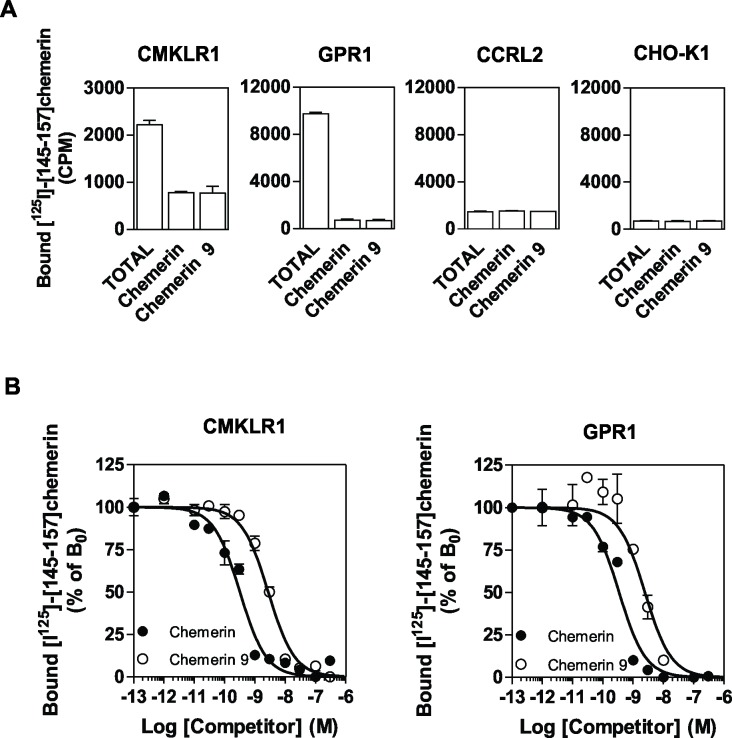
Peptide binding assay.A CHO-K1 cells expressing CMKLR1, GPR1 or CCRL2 were incubated with 0.1 nM [125I]-[145–157]-chemerin only (TOTAL) or 0.1 nM [125I]-[145–157]-chemerin in combination with an excess of chemerin or chemerin 9 as competitors. B. CHO-K1 cells expressing CMKLR1 or GPR1 were incubated with 0.1 nM [125I]-[145–157]-chemerin as tracer and increasing concentrations of unlabelled chemerin (●) or chemerin 9 (◯) as competitors. The data were normalized for nonspecific binding (0%) in the presence of 300 nM chemerin, and specific binding in the absence of competitor (100%). The displayed data represent the mean ± S.E.M. of three independent experiments.